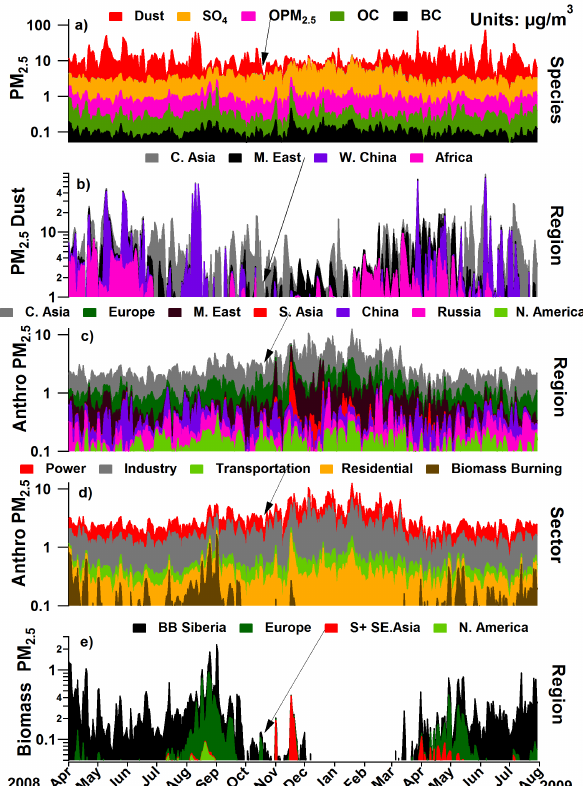
Figure 11. Simulated composition of PM 2 . 5 at the LST site by (a) species (µgm − 3 ) , (b) fine dust source regions (µgm − 3 ) , (c) anthro- pogenic PM 2 . 5 source regions (µgm − 3 ) , (d) anthropogenic PM 2 . 5 source (µgm − 3 ) , and (e) biomass PM 2 . 5 source regions (µgm − 3 ) . The contributions from source region and sectors denote the non- dust portion of PM 2 . 5 mass.